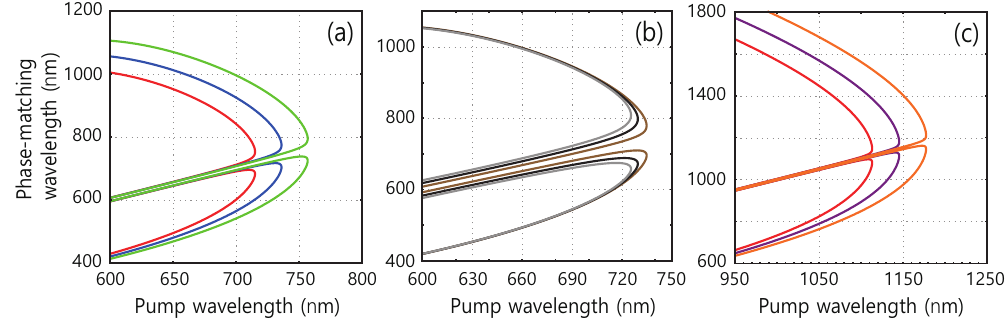
Figure 14. ( a ) Phase-matching curves of the signal and idler as a function of the pump wavelength at 610 nm (red), 615 nm (blue), and 630 nm (green) in diameter. Average pump power is 0.5 mW. ( b ) Power dependence of the phase-matching curves at 1.0 mW (brown), 5.0 mW (black), and 10 mW (gray) in average pump power. Here, d is fixed at 650 nm. ( c ) Phase-matching curves of the signal and idler as a function of the pump wavelength at 900 nm (red), 925 nm (purple), and 950 nm (orange) in diameter. Average pump power is 0.5